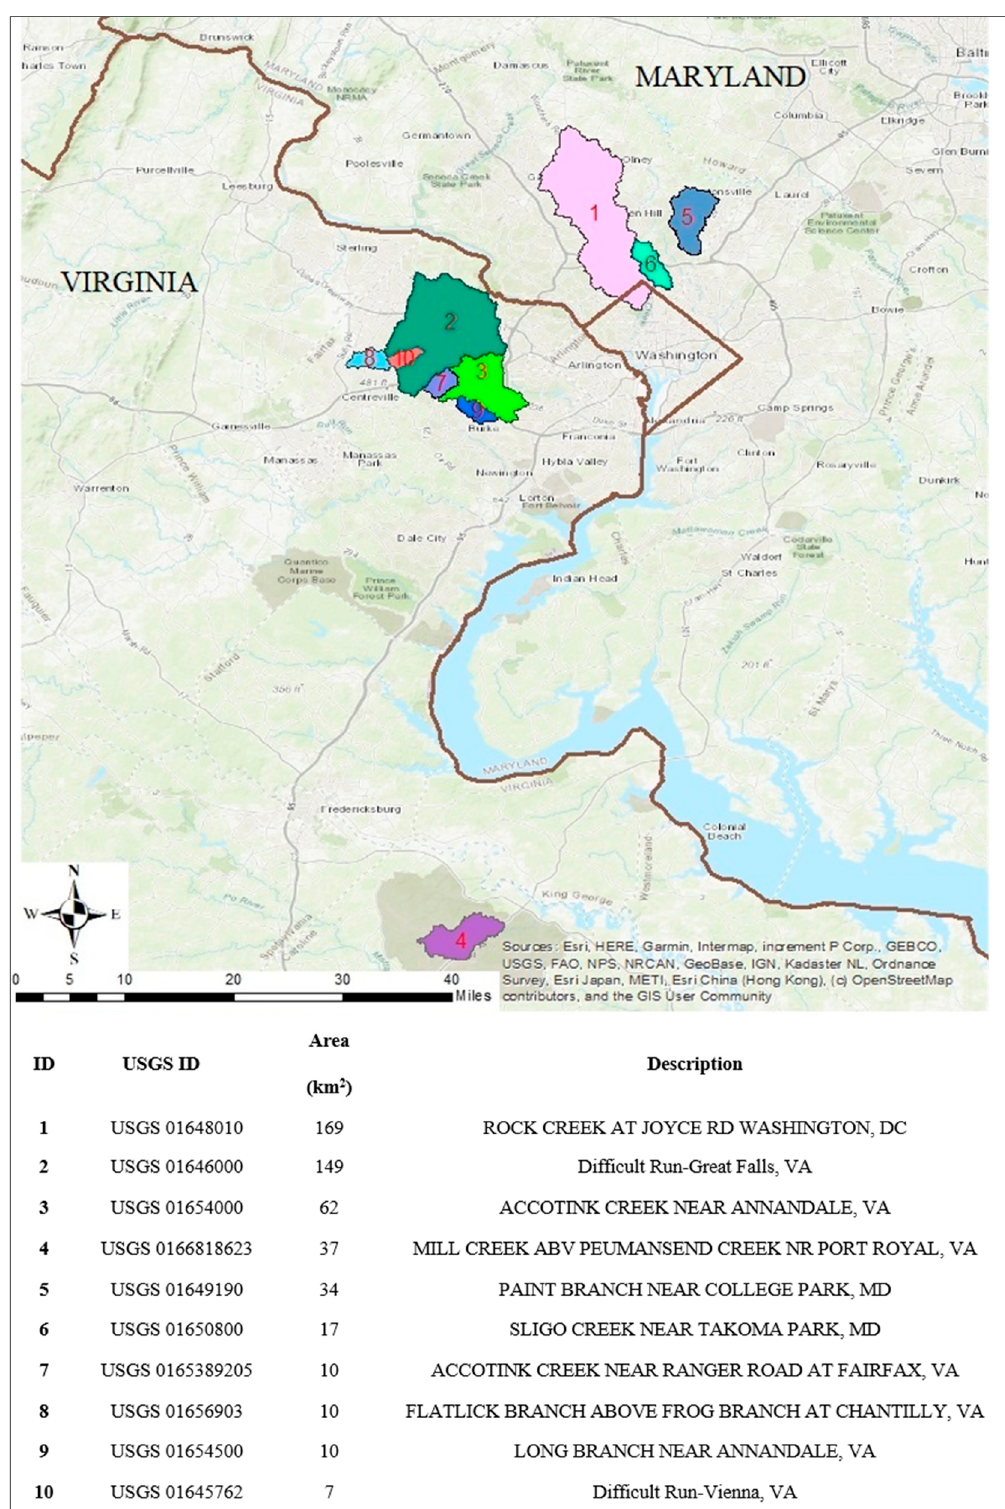
Figure 1. Location, area, and extension of the 10 watersheds selected for the study in the DMV region.